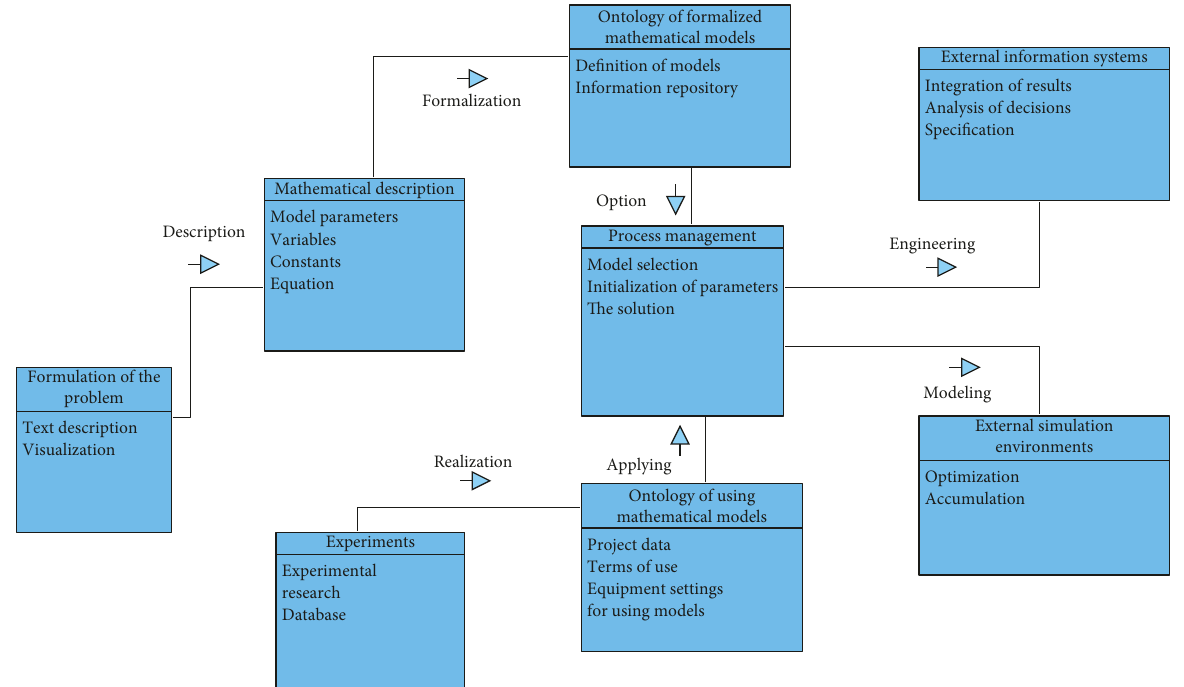
Figure 1: General scheme of implementing an ontological approach to mathematical